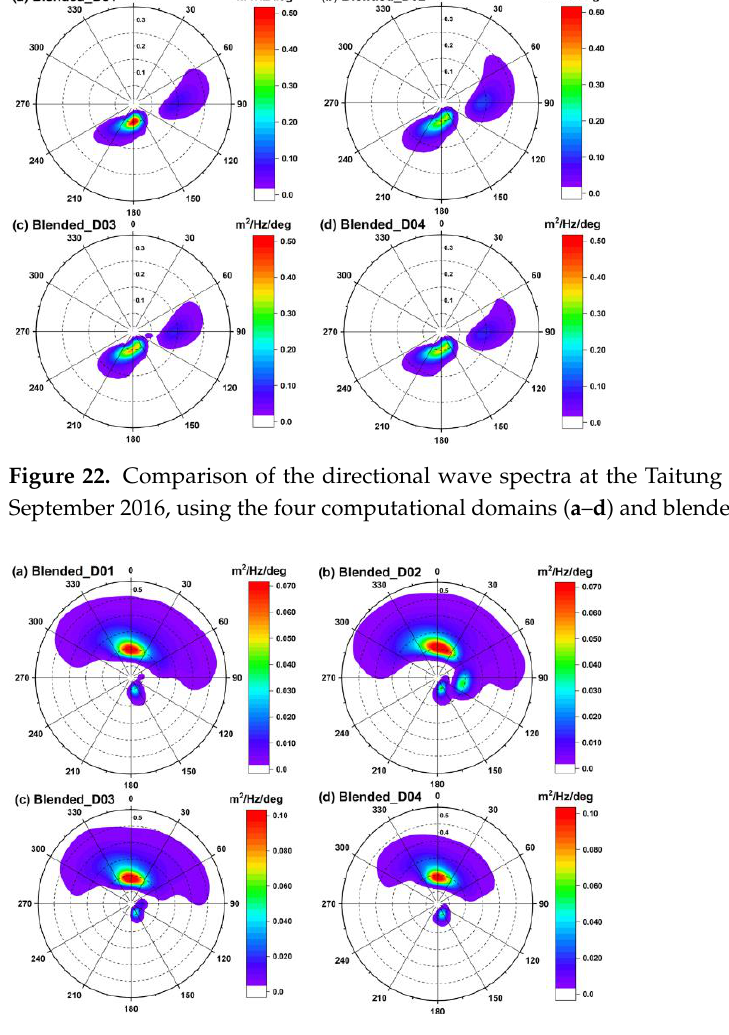
Figure 23. Comparison of the directional wave spectra at the Eluanbi wave buoy at 00:00 on 17 September 2016, using the four computational domains ( a – d ) and blended wind fields.